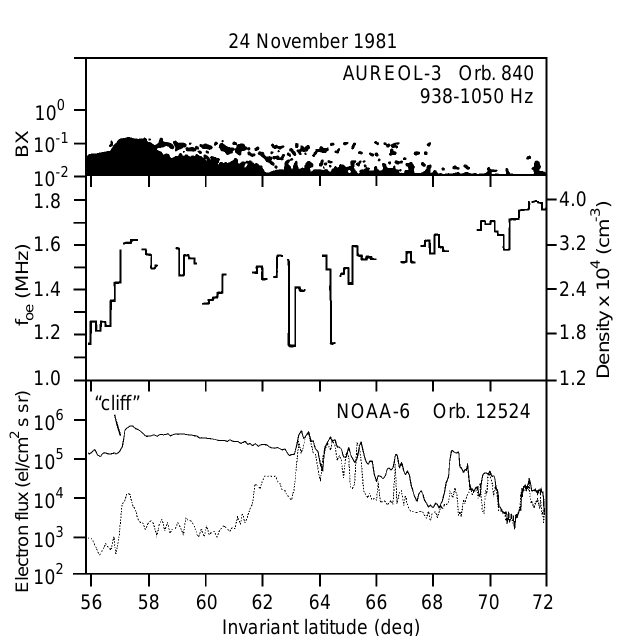
Fig. 9. Comparison of the cli(cid:128) location obtained from the NOAA satellite measurements ( bottom panel ) with the location of the ELF wave intensity maximum and sharp gradient of the plasma frequency registered by the Aureol-3 satellite ( top and middle panel , respectively) or ‘‘multiple plateau’’ and the outer edge of the cold plasma structure. According to the scheme, the cli(cid:128) is expected equatorward of the outermost gradient, close to the outer edge of the density trough.